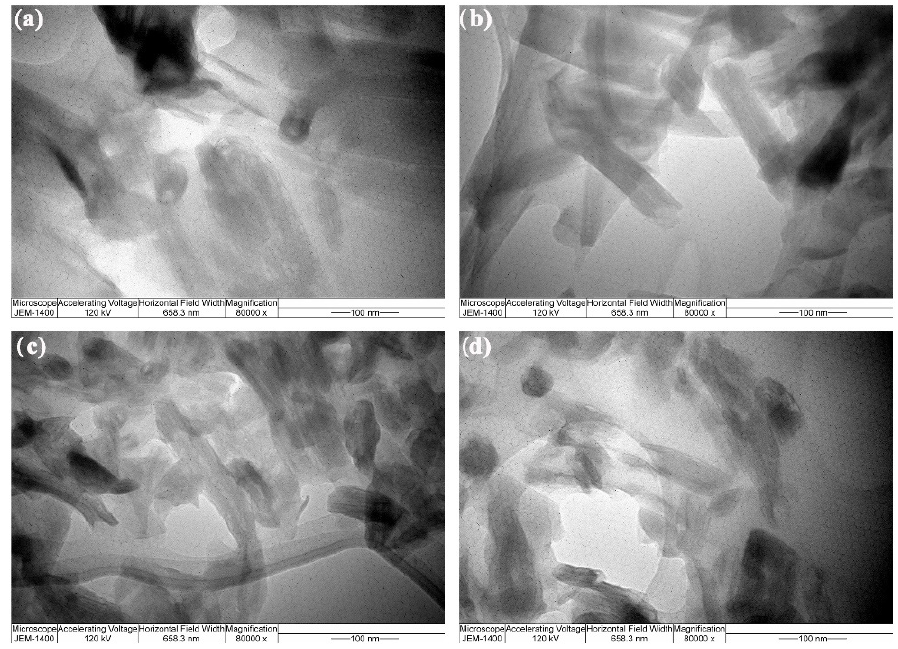
Figure 17. TEM images of ( a ) Ca 2 SiO 4 ; ( b ) Mg 2 SiO 4 ; ( c ) Ca 3 SiO 5 ; and ( d ) CaSiO 3 .